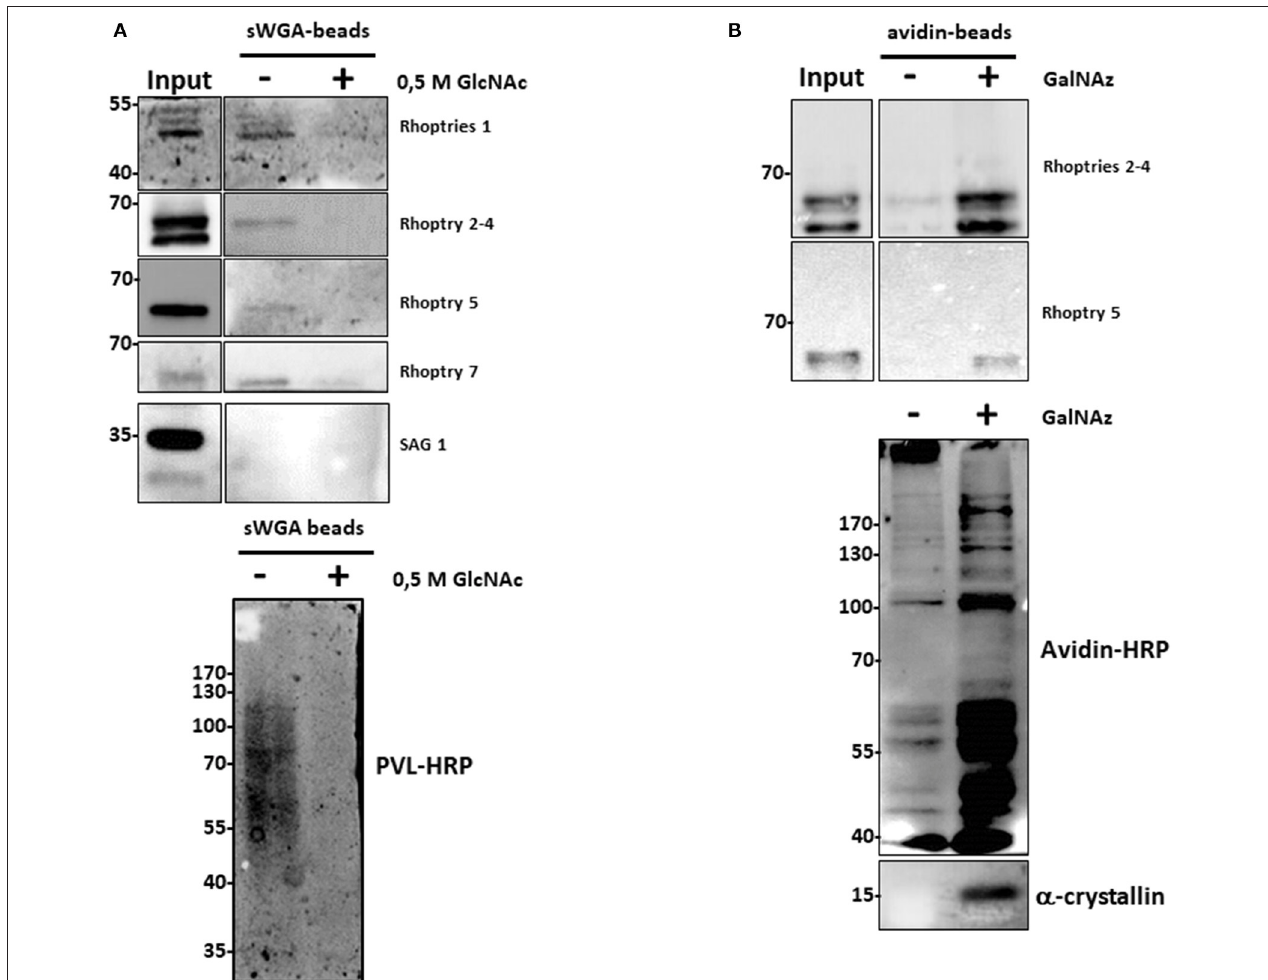
FIGURE 3 | (A) After enrichment on sWGA-beads as described in the materials and methods section, bound proteins were submitted to SDS-PAGE and Western blot. Membranes were probed with different anti-rhoptries antibodies, anti-SAG 1 antibody or with the lectin PVL-HRP. Specificity of PVL-HRP was confirmed by incubation in presence of free GlcNAc. (B) T. gondii proteins were enzymatically labeled with GalNAz and then chemically with avidin. Proteins were enriched by avidin-beads and samples were resolved by SDS-PAGE and western blotted. Membranes were probed with indicated anti-rhoptries antibodies. Control was performed by staining clicked-proteins with avidin-HRP. Alpha-crystallin was used as a control of labeling.